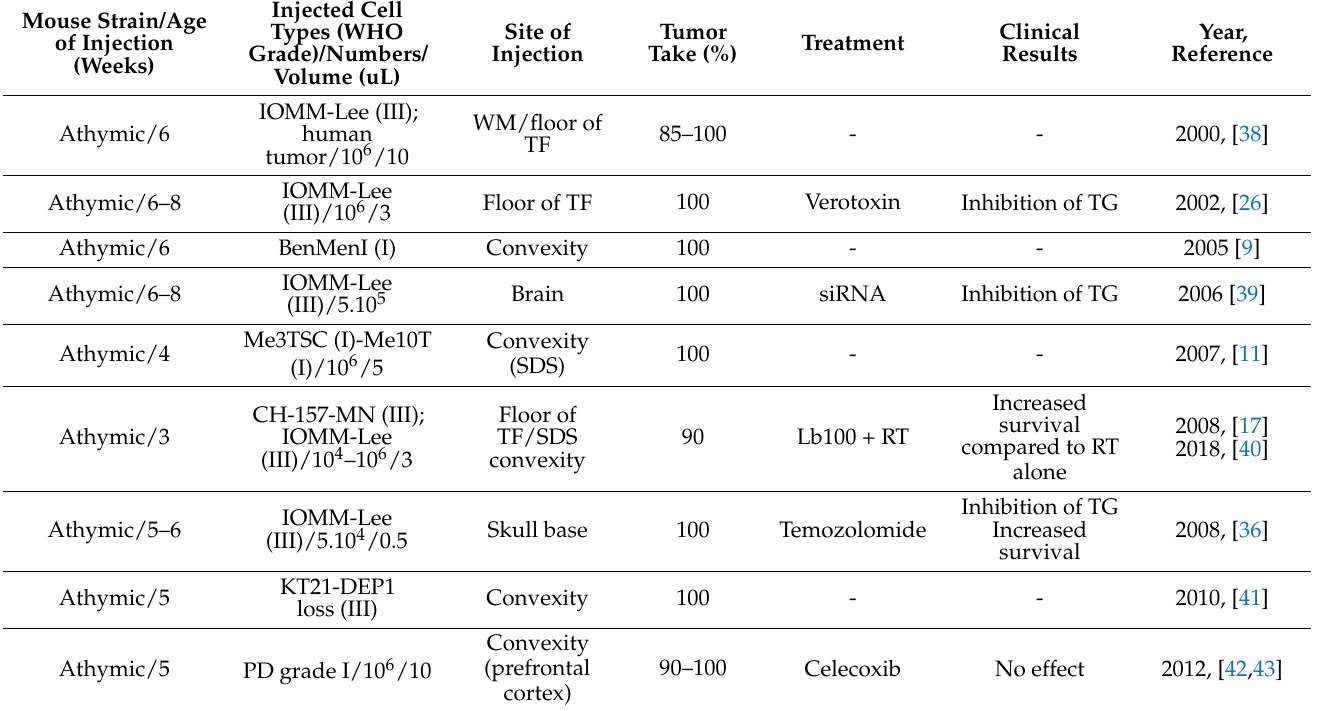
Table 2. Summary of meningioma orthotopic xenograft